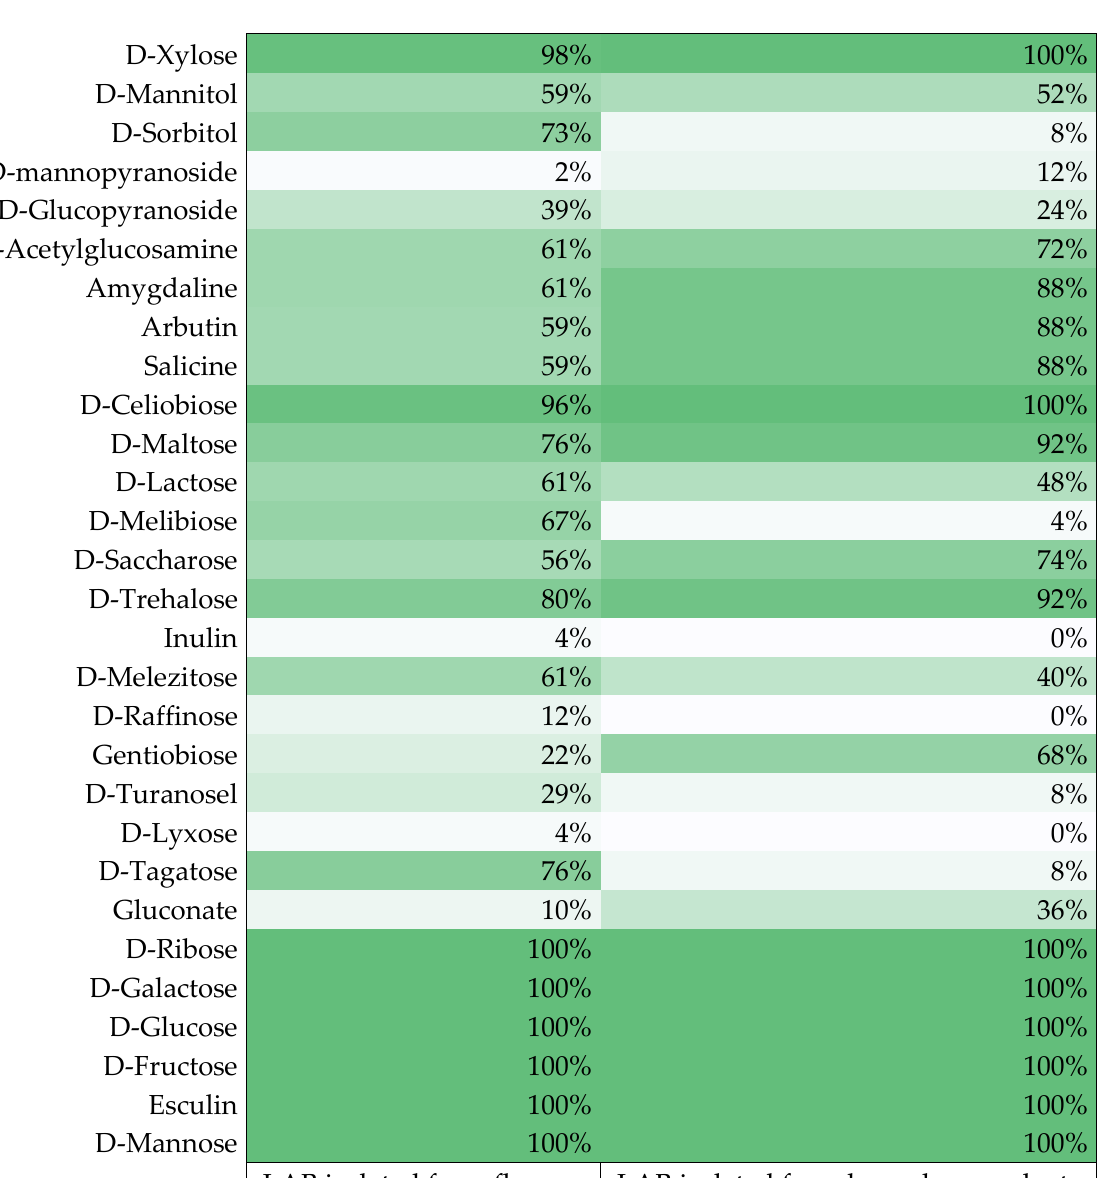
Figure 3. Percentage of isolated LAB strains capable of utilizing given sugars.